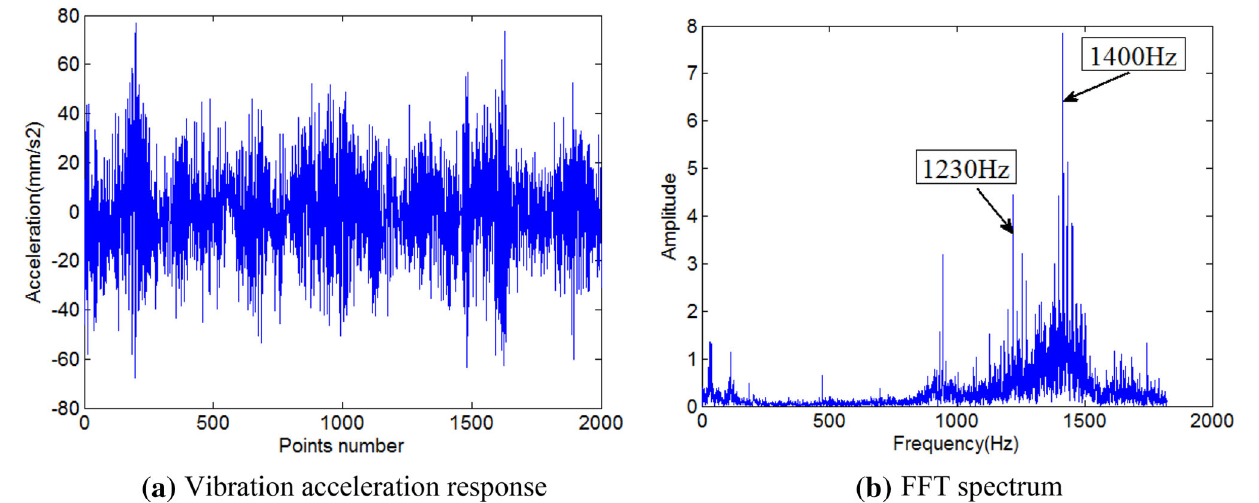
Fig. 8 Beat vibration phenomenon in mearured vibration signals